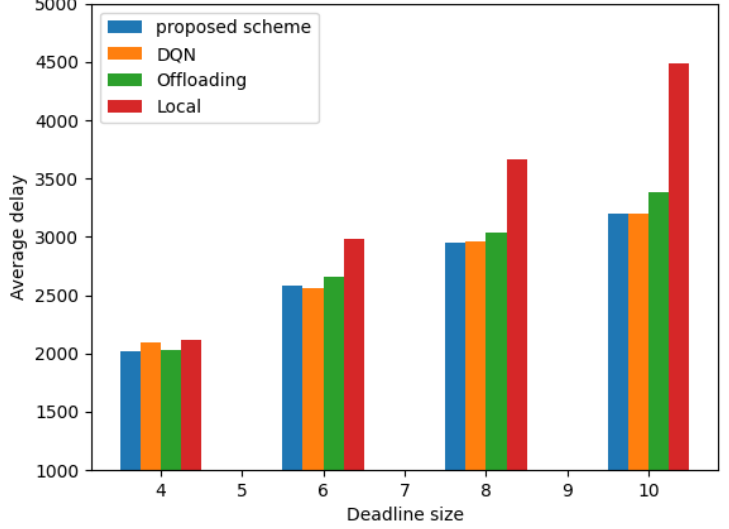
Figure 6. Average delay evaluation with different